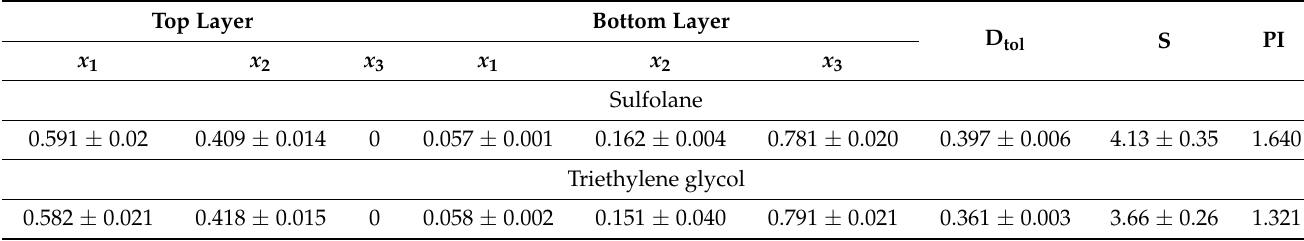
Table 10. Composition of the experimental tie-lines (mole fraction), the toluene distribution ratio (D), selectivity (S), and the performance index (PI) for the ternary system {1-hexene (1) + toluene (2) + solvent (3)} at 298.15 K and 101.325